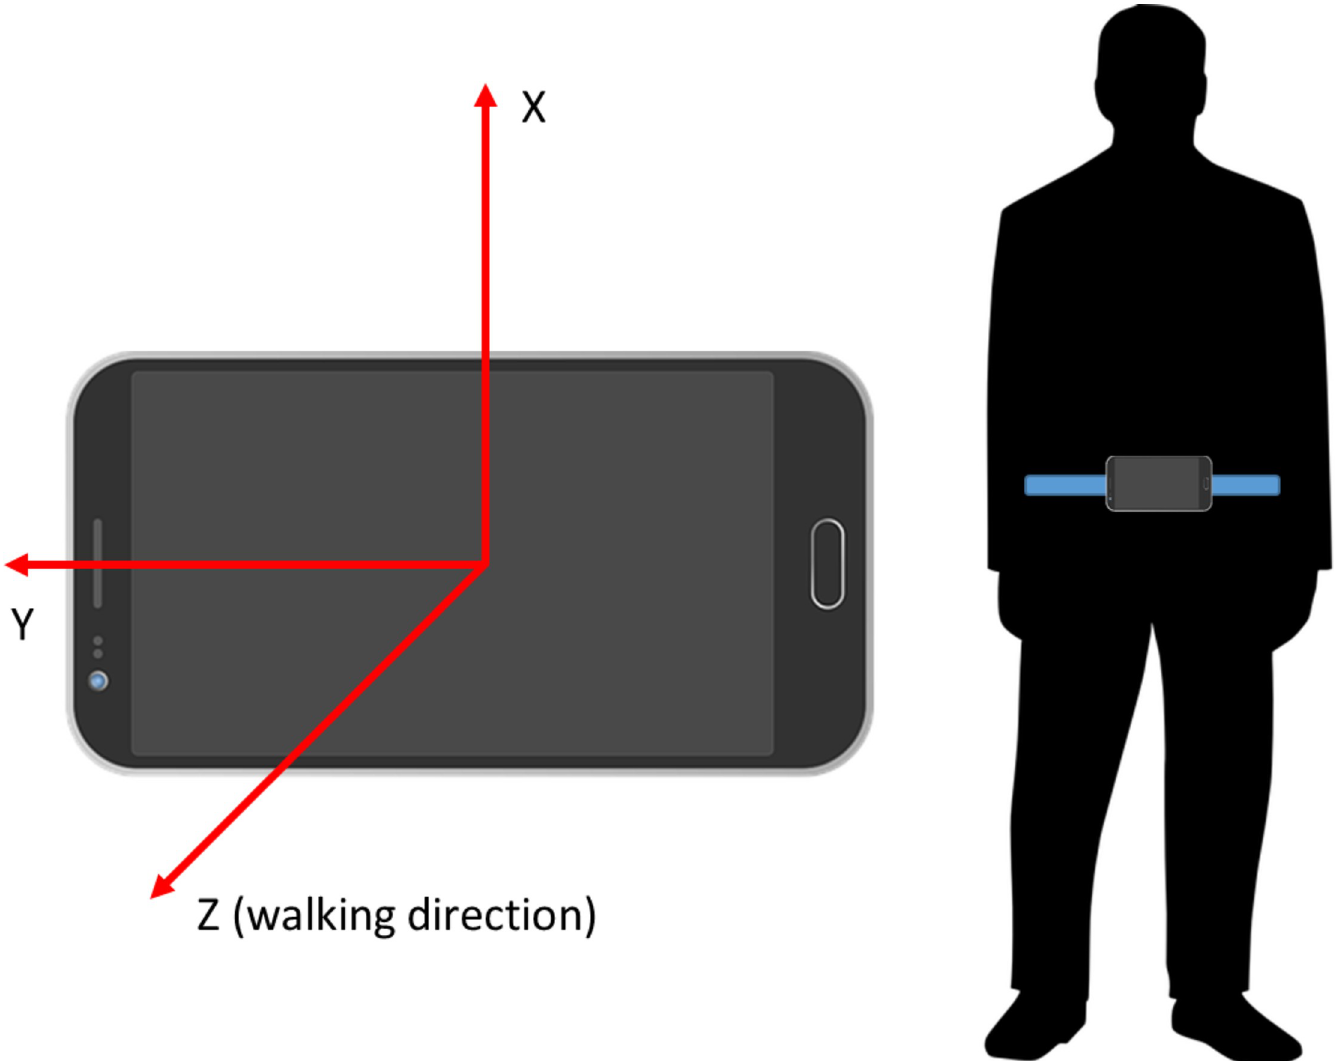
Fig 3. The orientation of the smartphone during 20 step walking tests: X, Y and Z axes denote up-down, right-left and forth-back directions, respectively. Positive Z axis denotes the walking direction, when walking a straight line.